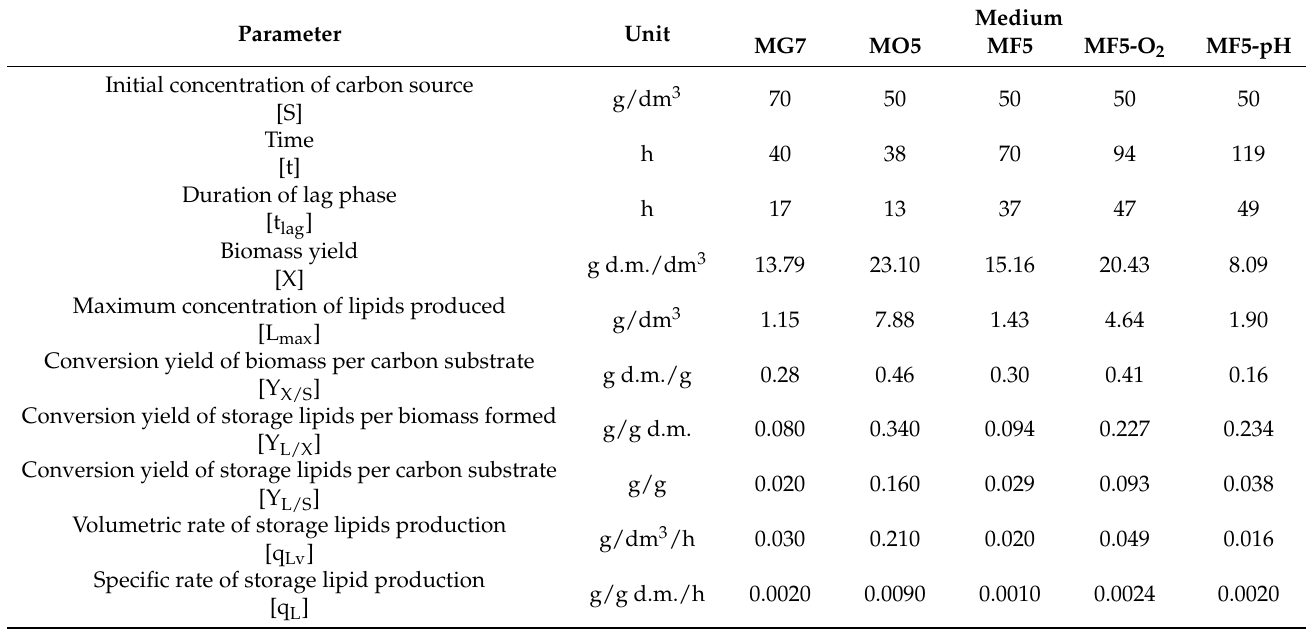
Table 3. Parameters of storage lipids biosynthesis in a batch bioreactor culture of Y. lipolytica in media with fish waste oil as a sole carbon source (MF5) and MO5 (olive oil) and MG7 (glucose) control media. The variants with oxygenation (MF5-O 2 ) and pH regulation (MF5-pH) were also